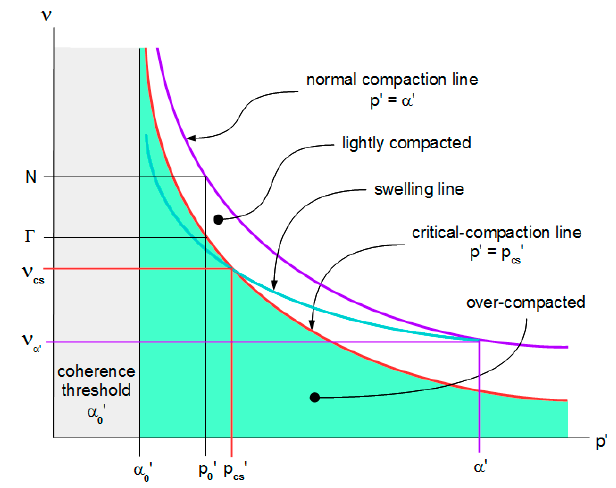
Figure 2. Normal compaction, swelling and critical-compaction lines.